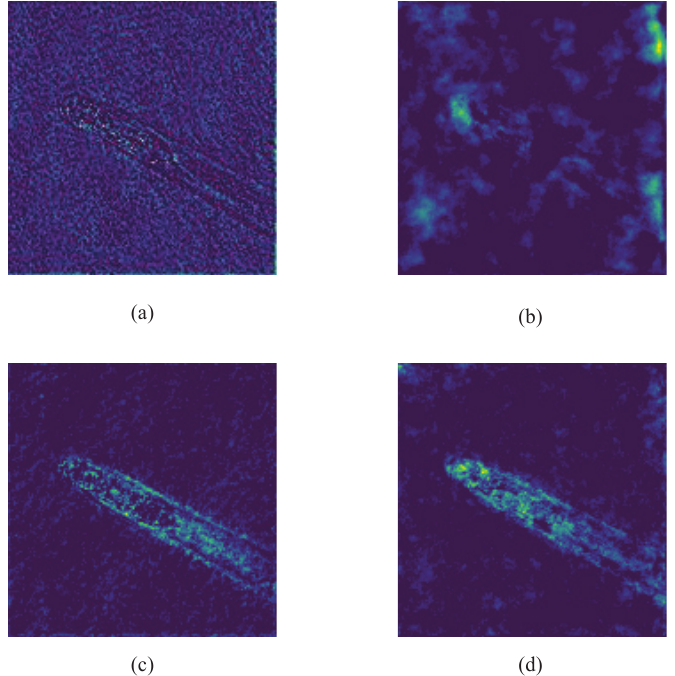
Figure 3. An example of feature maps: ( a ) a low-level feature map in the backbone; ( b ) a merged feature map that combines an original low-level feature with a high-level feature through jump connection; ( c ) a low-level feature map after STB processing; ( d ) a merged feature map that merges a STB processed low-level feature with a high-level feature through jump